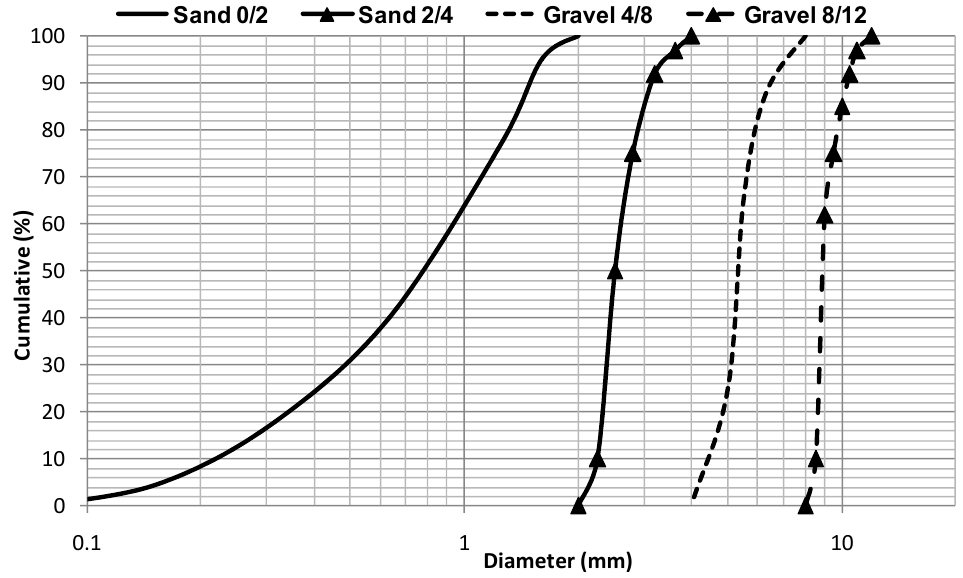
Figure 1. Particle-size distribution curve of sand and gravel.